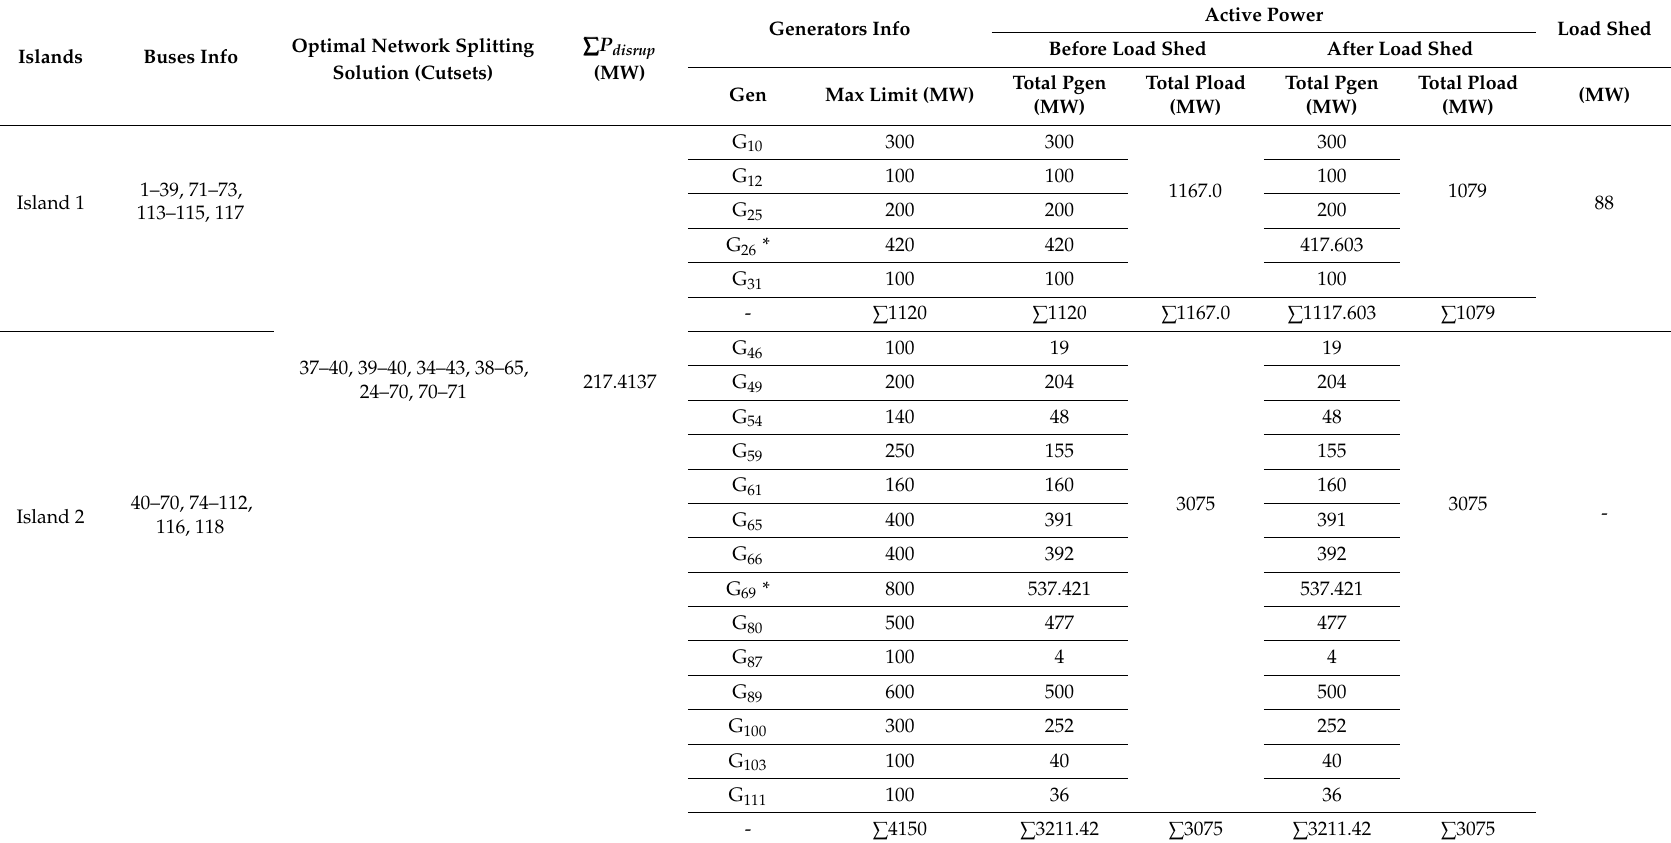
Table 5. IEEE 118 data after network splitting for Case